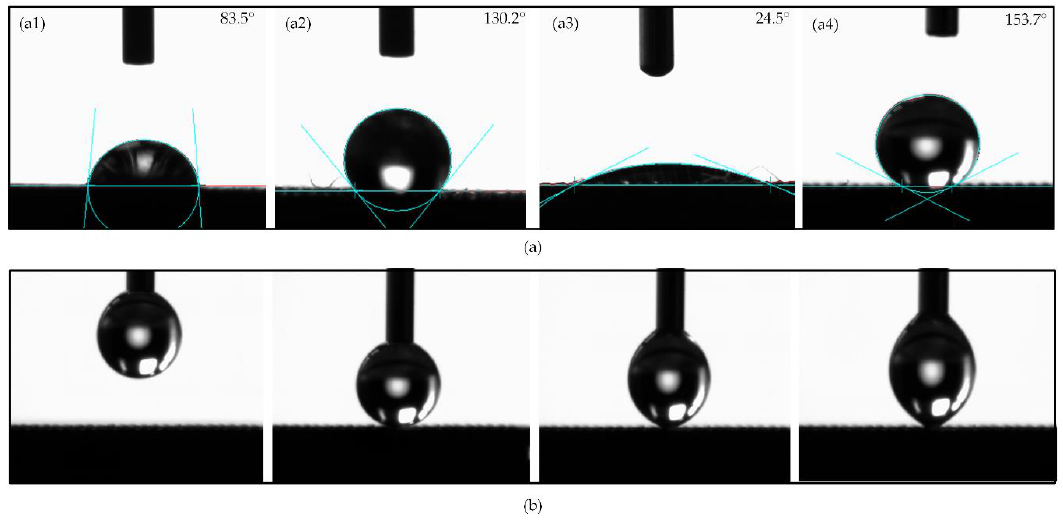
Figure 7. ( a ) Contact angle (CA) of (a1) P Ti. (a2) M Ti. (a3) MN Ti. (a4) F Ti. ( b ) The measurement process of CA of F Ti.